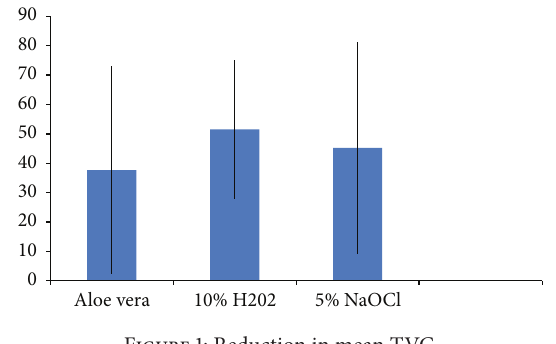
Figure 1: Reduction in mean TVC. Table 1: Mean TVC of the three disinfectants.